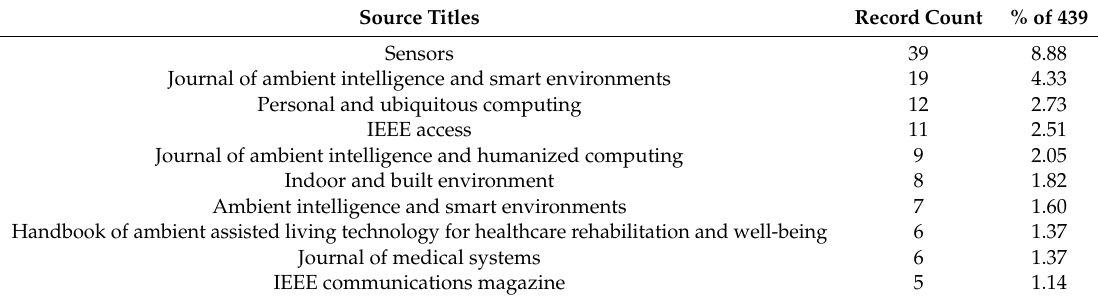
Table 1. Top ten journals for “Smart ICT Solution” AND “Elderly” in ISI WOK . (Where ICT stands for information and communication technology).